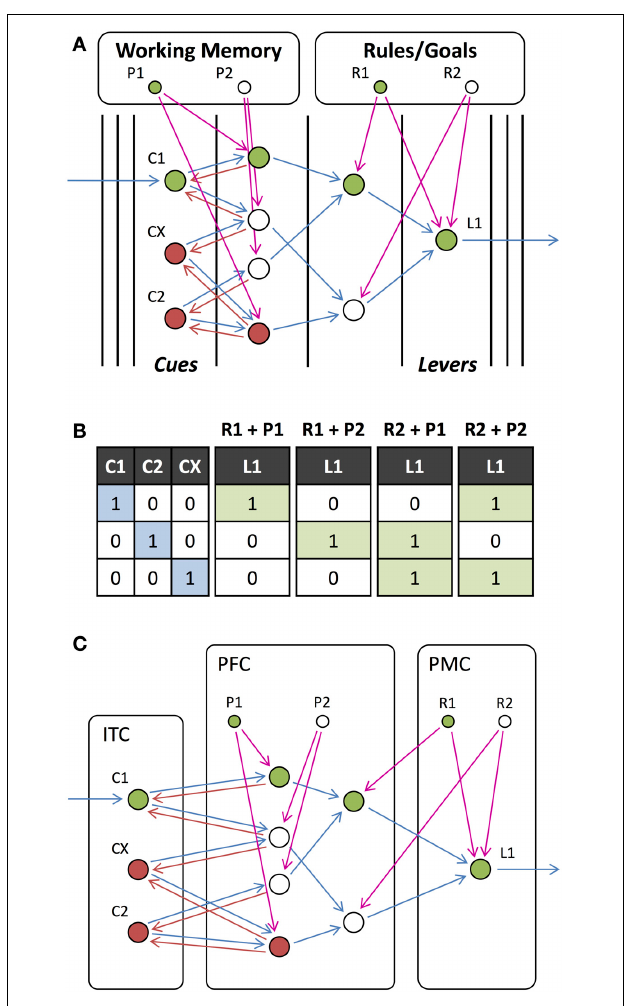
FIGURE 10 | Stimulus-matching Experiment. (A) Network for responding to a stimulus (C1, C2 or any other stimulus CX), which is dependent on the current rule that determines whether to respond to a match or non-match with the previous stimulus. In contrast to previous tasks, working memory is required to remember the previous stimulus (P1 and P2 which correspond to the same stimulus as C1 and C2, respectively) in the same way that the rules (R1 and R2) are remembered. (B) Input-output table for the network presented with a stimulus for combinations of rules and remembered stimuli. (C) Same network as in (A) but with units assigned to anatomical regions of the